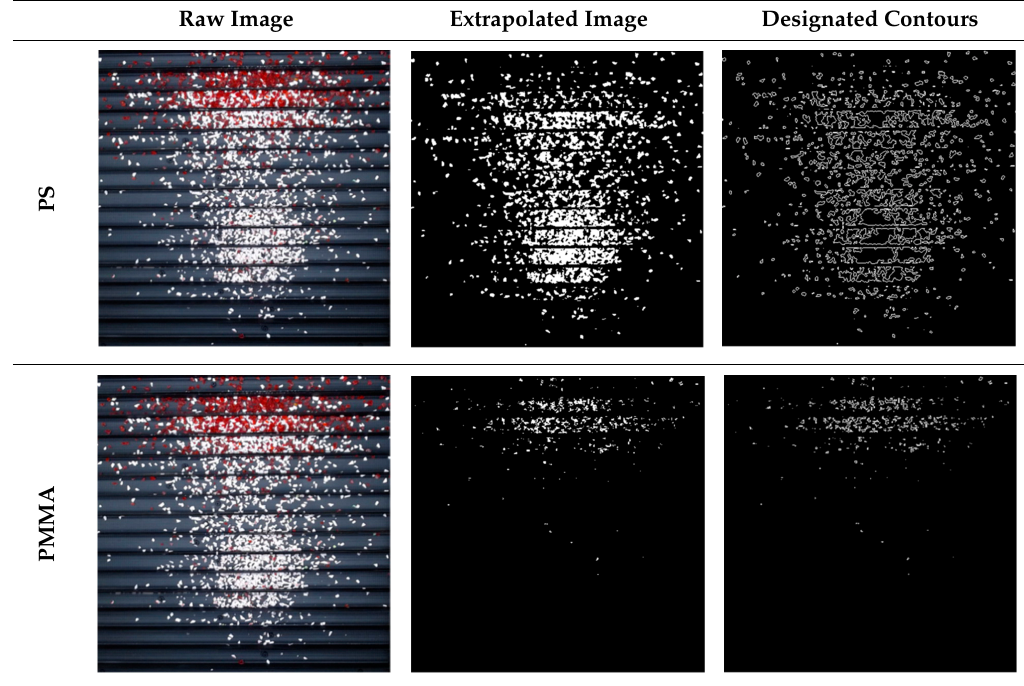
Table 3. Tests with separator—corona charging mode.